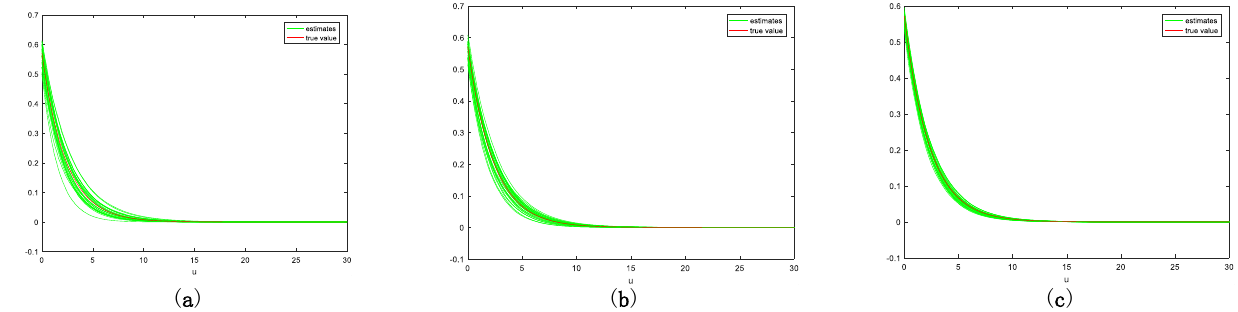
Figure 1. Estimation of the ruin probability for exponential claim size density: ( a ) T = 120 , ( b ) T = 180 , ( c ) T = 360.